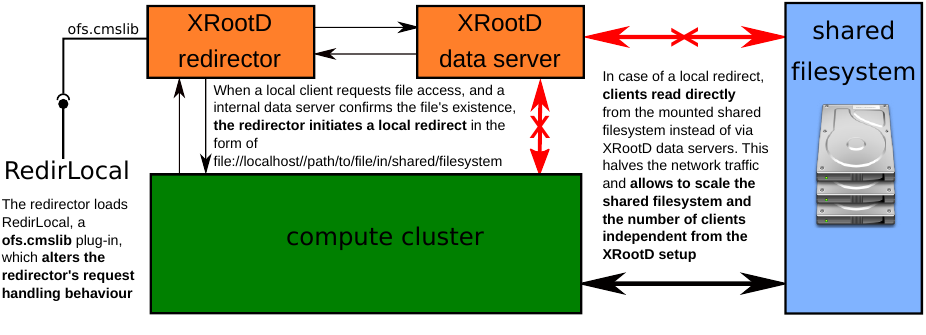
Figure 1. Local redirection via a redirector